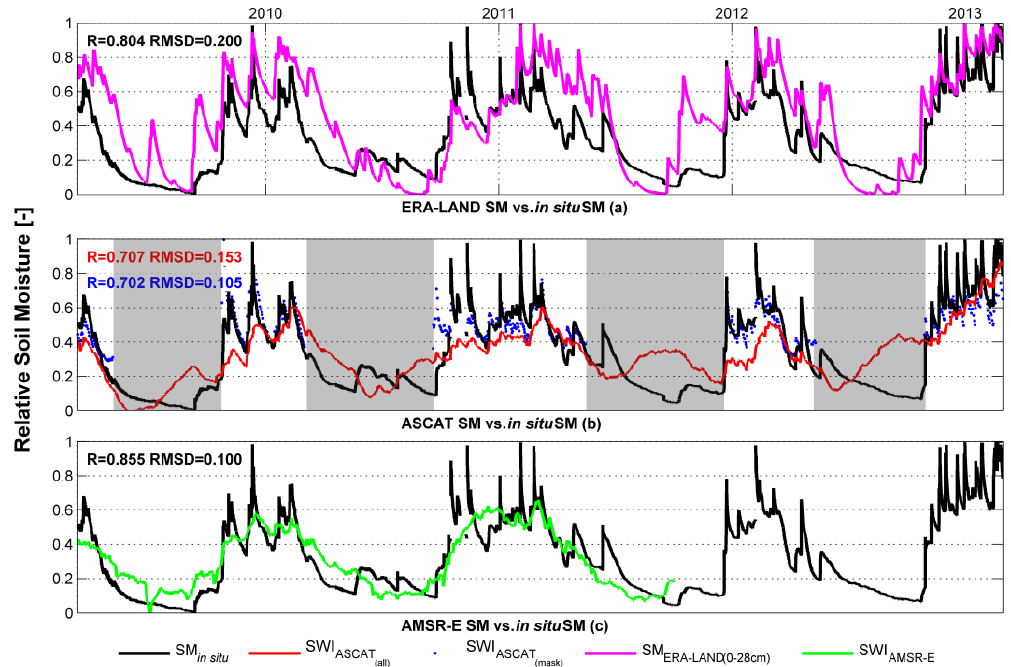
) obtained from 9 ERA-LAND(0-28cm)